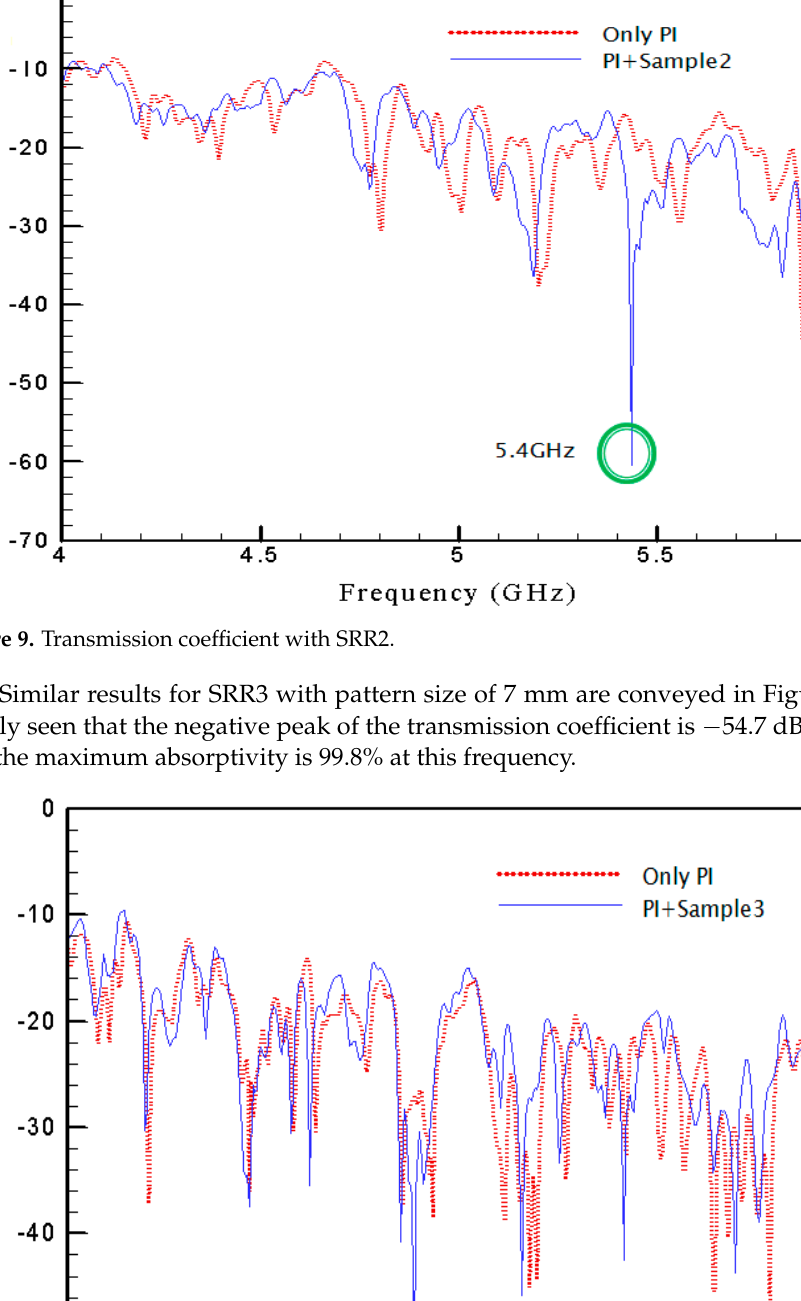
Figure 8. Transmission coefficient with SRR1.